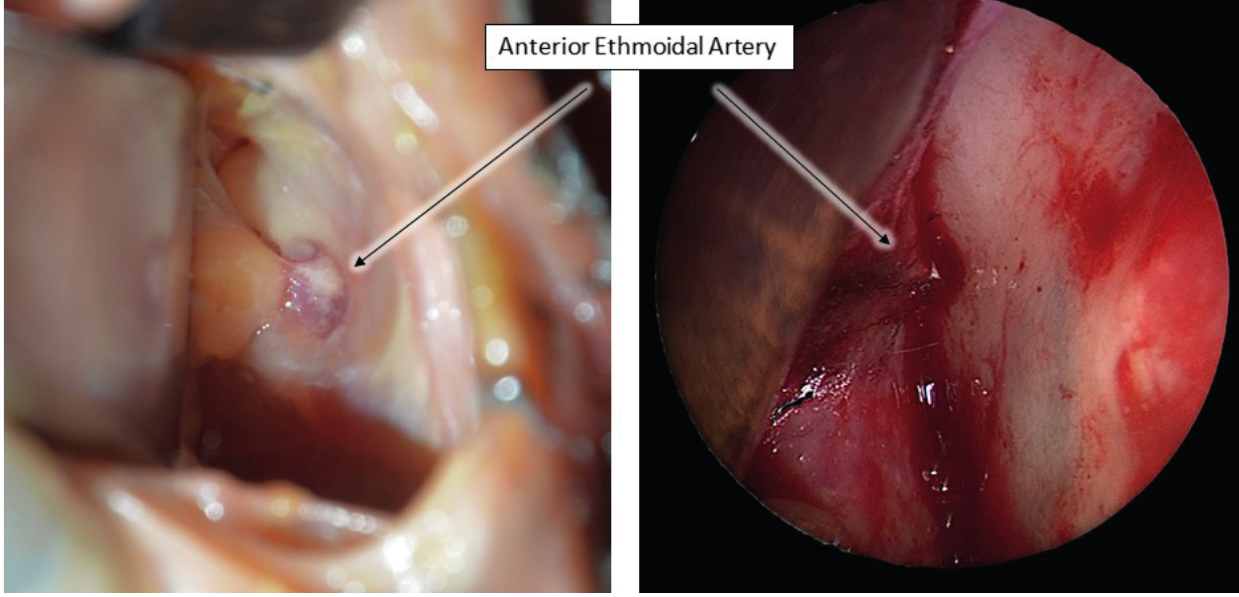
which often includes use of powered